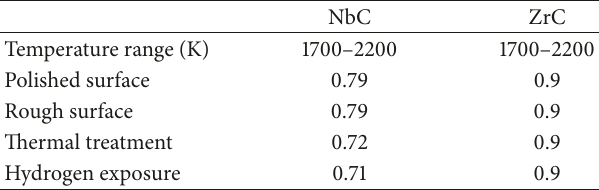
Table 2: Emissivity coefficients of NbC and ZrC.